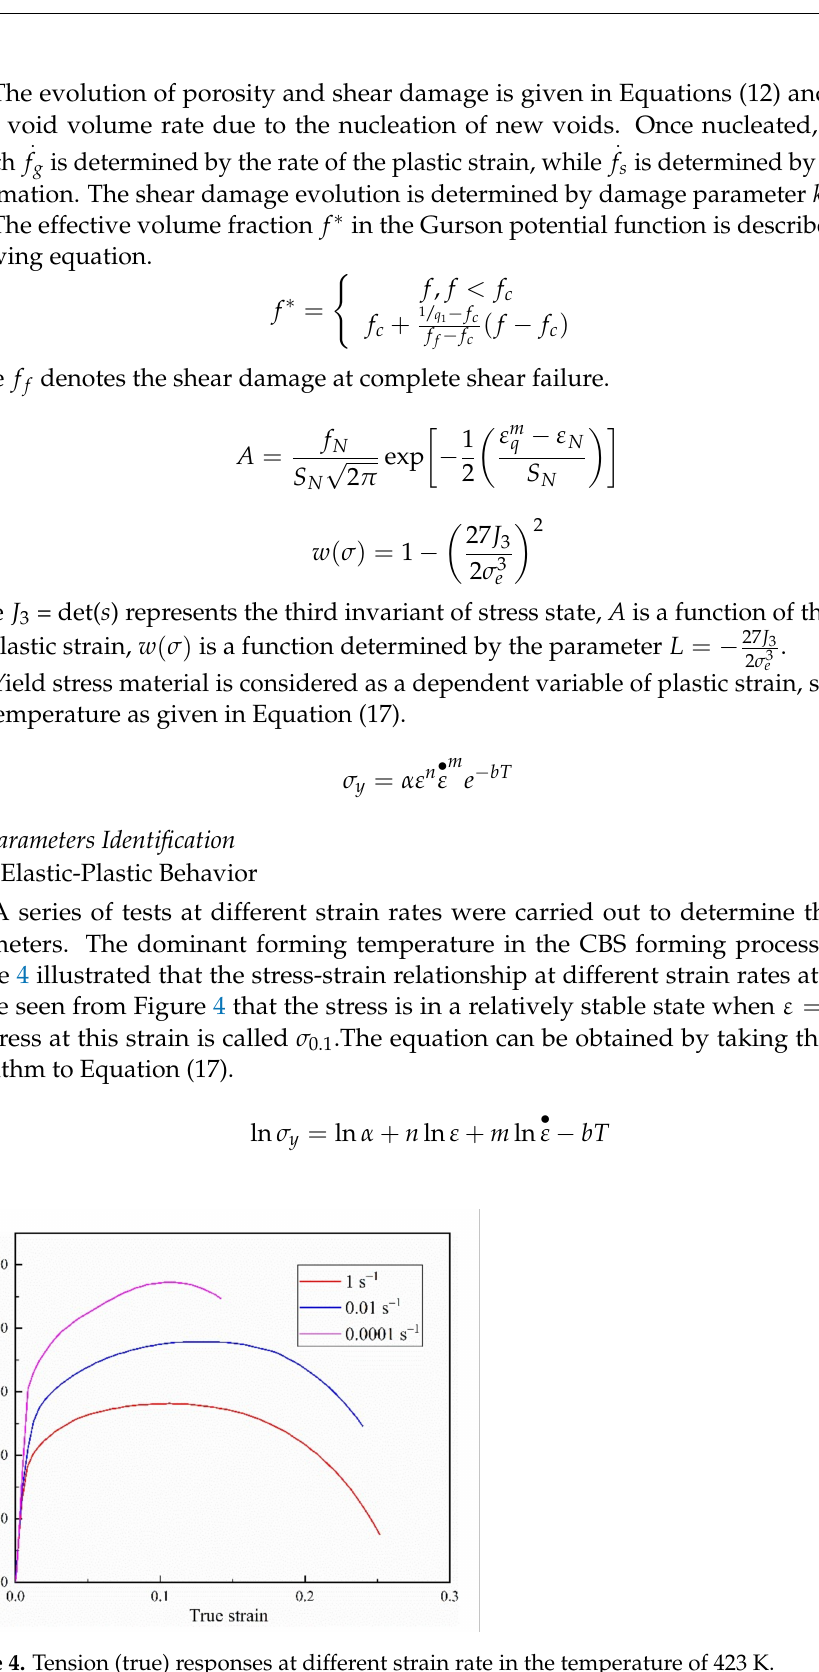
Figure 4. Tension (true) responses at different strain rate in the temperature of 423